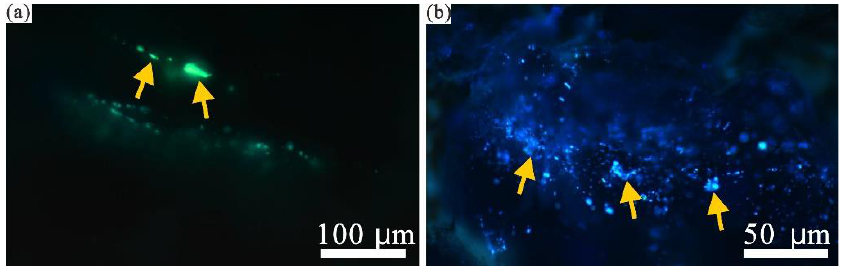
Figure 11. Micrographs of hydrocarbon inclusions in the J 1 a Formation under UV light in the Well DB102. ( a ) Yellow fluorescence; ( b ) blue-white fluorescence.